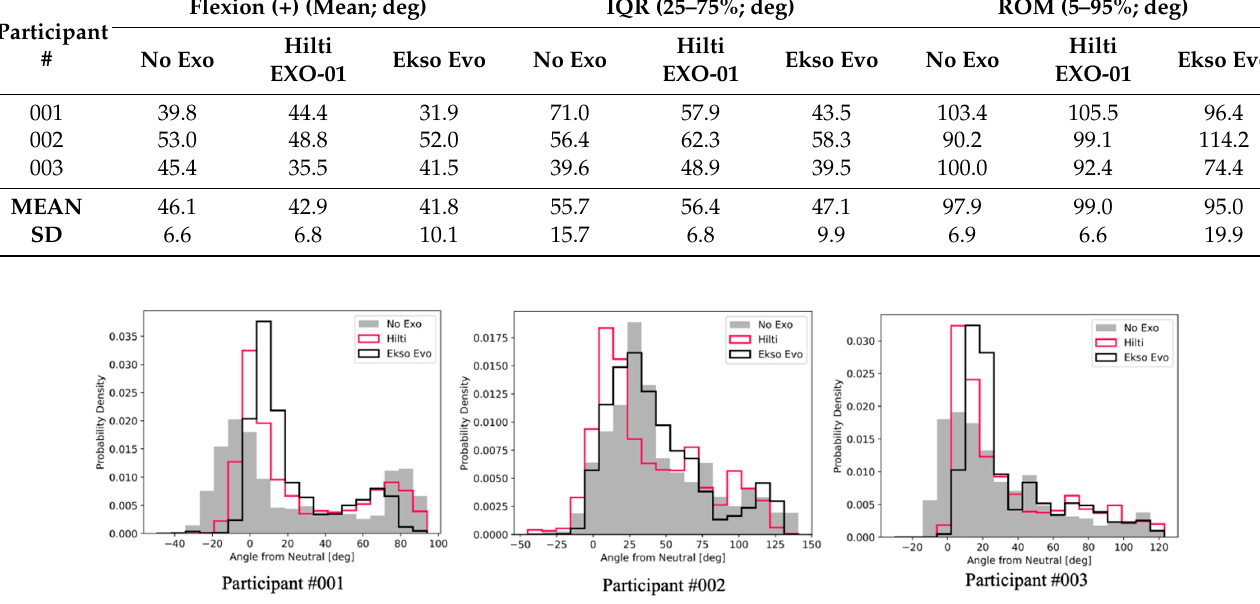
Figure 9. Histograms of flexion/extension of the right shoulder for block installation.